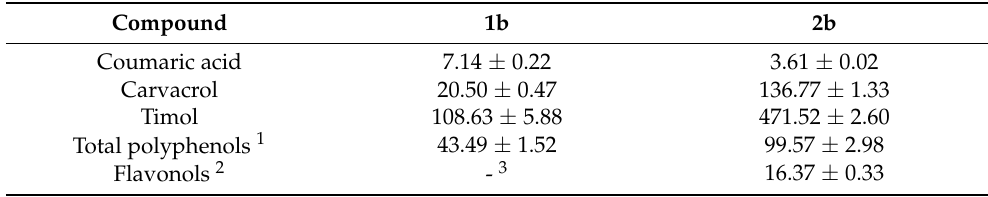
Table 1. HPLC-DAD quantitative analysis of the SPE Soxhlet oil , 1b, and scCO 2 oil, 2b . Results are expressed in µg/g of crude oil.